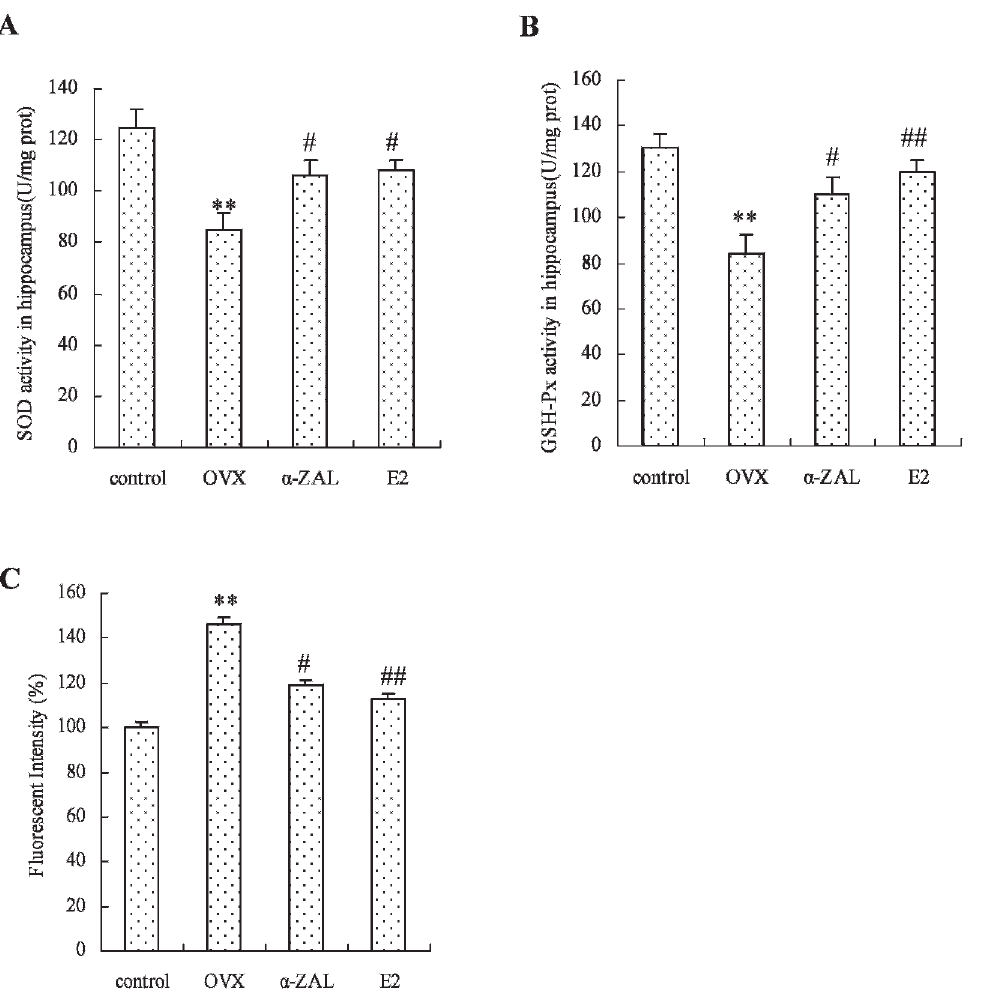
Figure 2 - E2 and a -ZAL effectively reversed the decrease in anti-oxidative enzyme activities (A and B) and the increase in ROS generation (C) in hippocampal tissues in OVX mice. The data are expressed as the mean ¡ SEM (n=6 in each group). ** p , 0.01 vs. control group; # p , 0.05 and ## p , 0.01 vs .